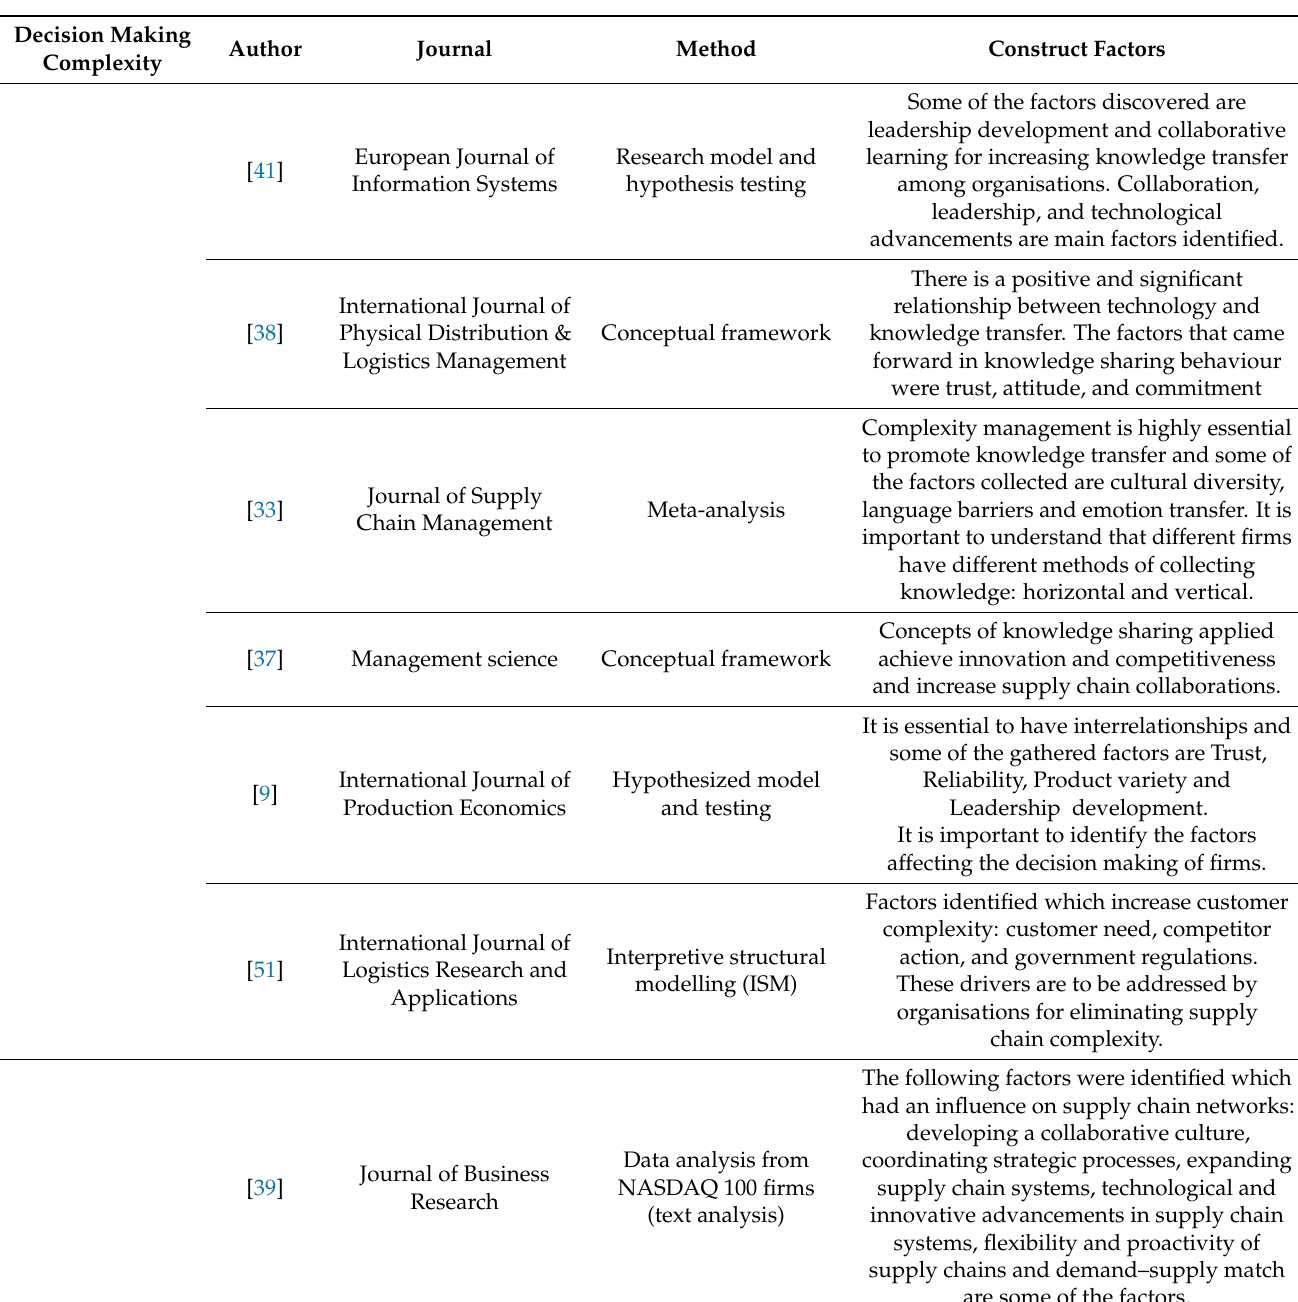
Table 6. Construct Factors for Decision-Making complexity (author’s